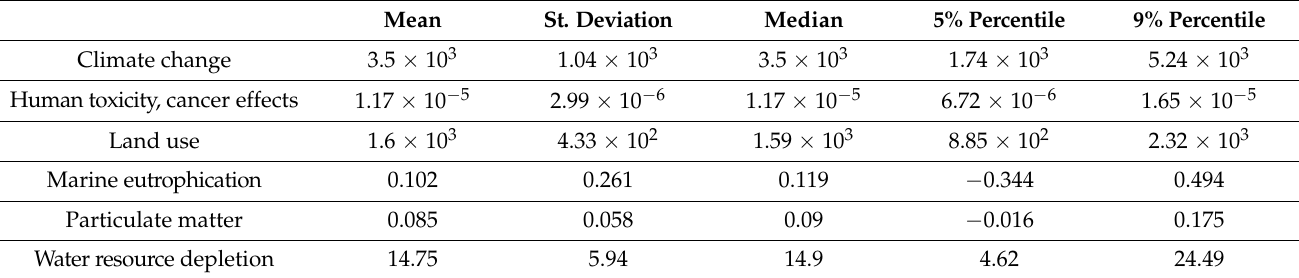
Table 4. Normal statistical distribution properties of results.